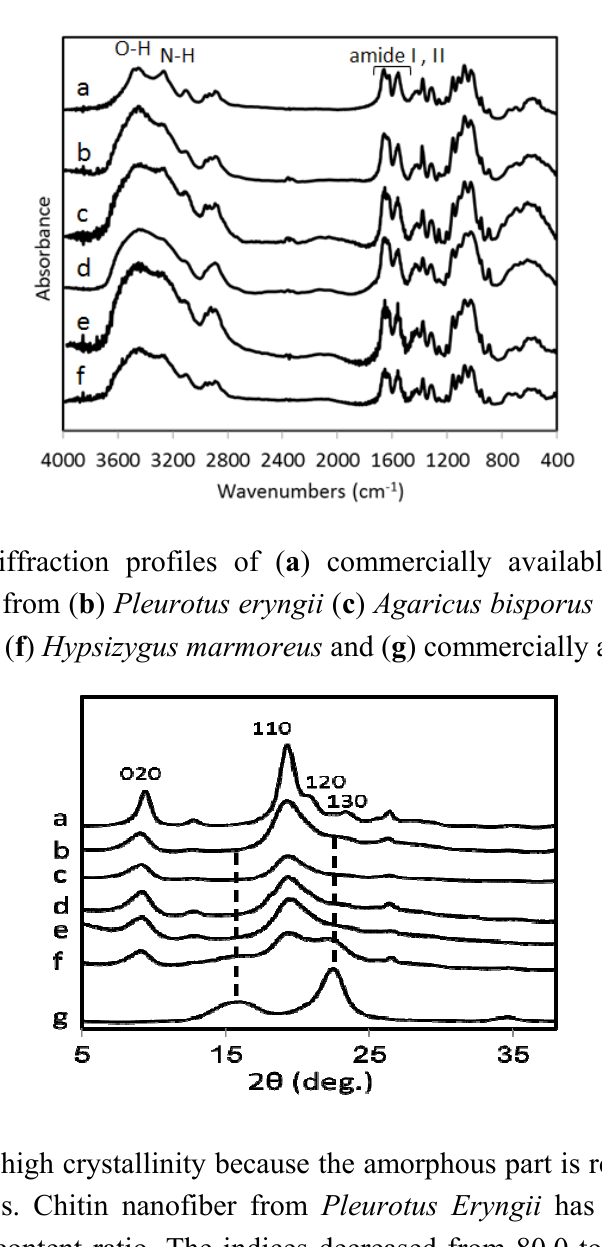
Figure 4. FT-IR spectra of ( a ) commercially available chitin, and chitin nanofibers prepared from ( b ) Lentinula edodes ( c ) Pleurotus eryngii ( d ) Hypsizygus marmoreus ( e ) Grifola frondosa and ( f ) Agaricus bisporus .